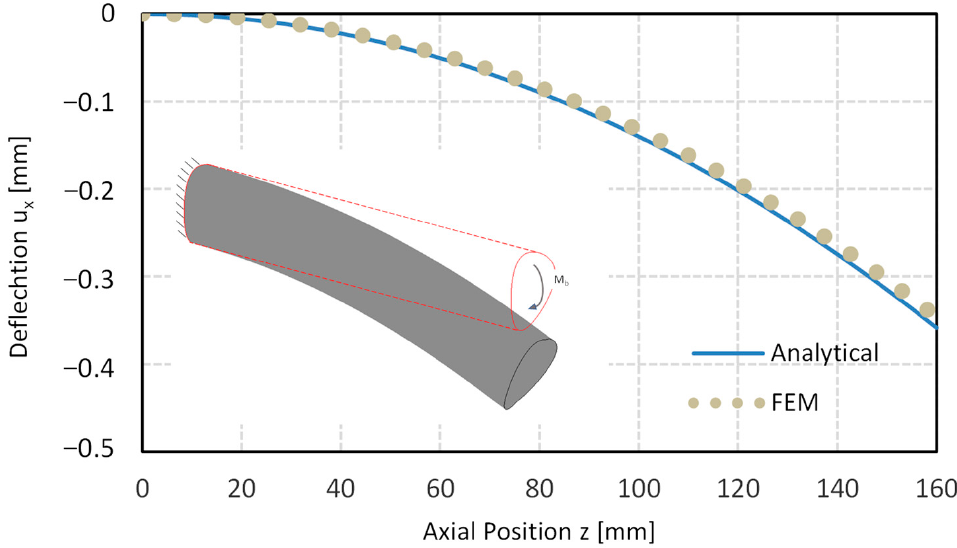
Figure 13. Deflection in a DIN3689-H3-40 × 32.73 profile shaft.